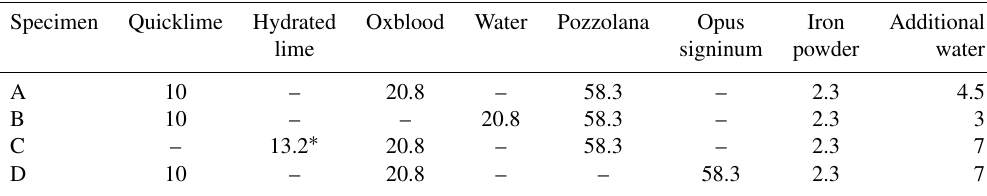
Table 2. Compositions of the mortar mixes in weight (g).